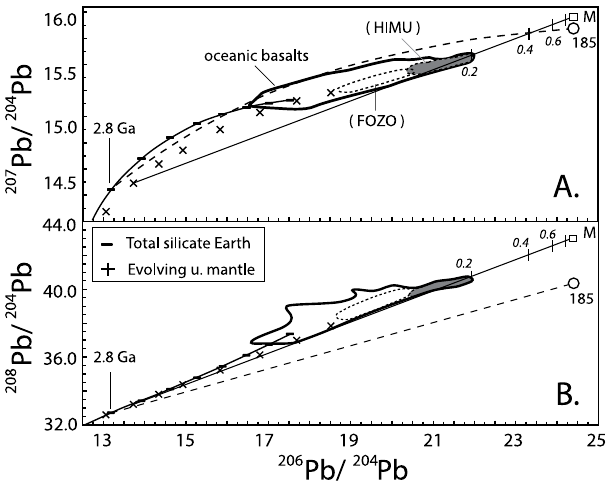
Figure 3. 206 Pb/ 204 Pb versus A. 207 Pb/ 204 Pb and B. 208 Pb/ 204 Pb diagrams showing the evolution of the carbonate fraction of sample 185 from the 2.8 Ga Bulk silicate Earth 7 to present (dash lines), and our model for the origin of HIMU OIB (solid lines). The model was constructed by metasomatizing (mixing) 99% of a slightly younger, 2.4 Ga evolving upper mantle ( 206 Pb/ 204 Pb = 13.728, 207 Pb/ 204 Pb = 14.614, 208 Pb/ 204 Pb = 33.210, 0.051 ppm Pb) ref. 7 with 1% of a hypothetical Archaean limestone ( 206 Pb/ 204 Pb = 24.404, 207 Pb/ 204 Pb = 16.200, 208 Pb/ 204 Pb = 43.00; open square – M) containing the Pb of the most enriched, 8% partial melt from carbonated pelite (67.2 ppm; see ref. 41 for details of experimental data, and modeling). The latter Pb concentration was used because of the dearth of experimental data for partial melting of limestone at high pressures. Each upper mantle and total silicate Earth symbol represents 0.4 Ga interval whereas each tick mark along the model mixing line represents 0.2 increment of melt contribution. See text for additional